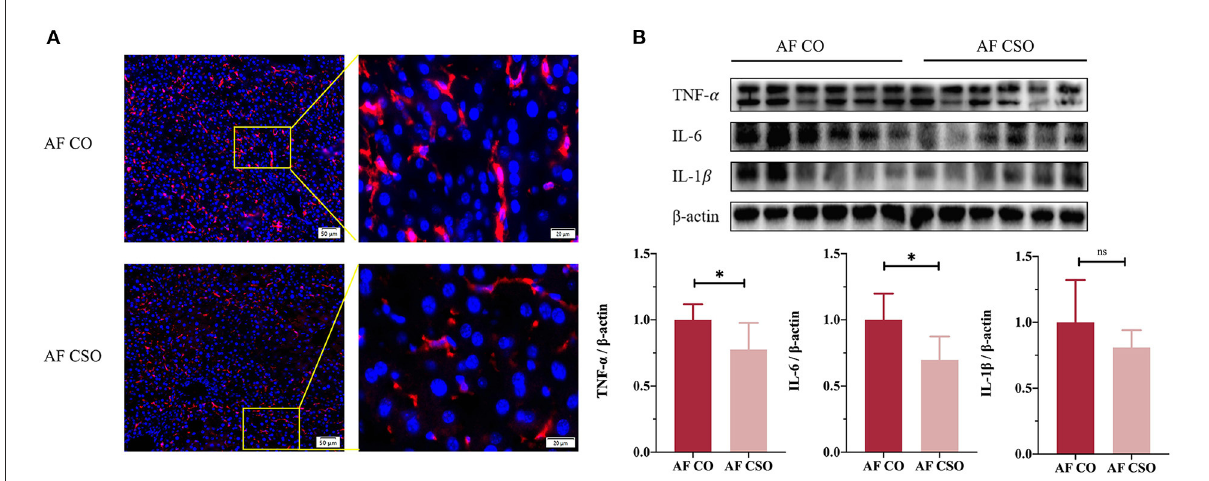
FIGURE3 Dietary CSO supplementation improves alcohol-induced liver inflammation. (A) Representative immunofluorescent staining of F4/80 in mouse liver sections. Higher magnification of the indicated area (box) was shown in right. Red = F4/80, blue = DAPI (nuclei). Scale bars, 50 (left) and 20 (right) µ M. (B) Protein maps and quantitative plots of TNF- α , IL-6, and IL-1 β in mice livers. * P < 0.05 indicates statistically significant differences.